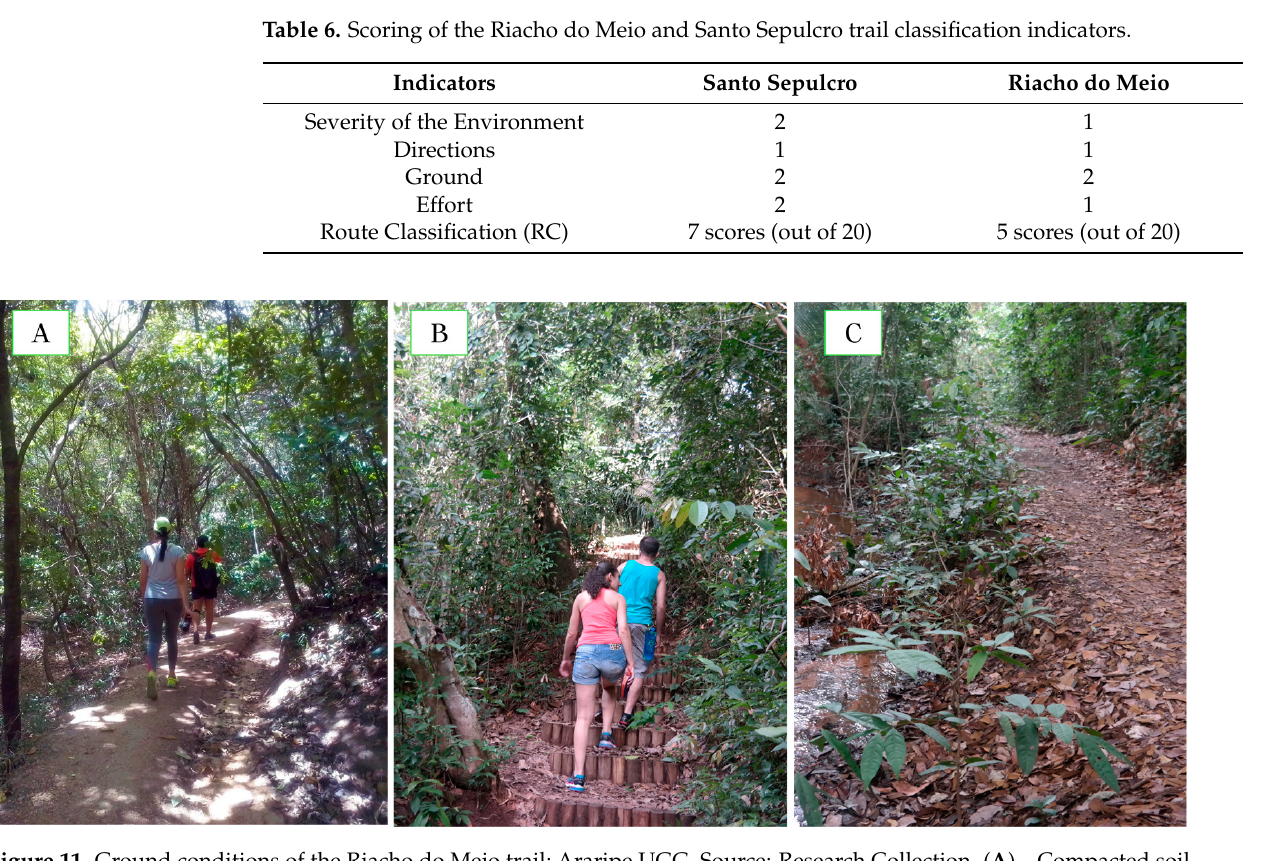
Figure 11. Ground conditions of the Riacho do Meio trail; Araripe UGG. Source: Research Collection. ( A )—Compacted soil and single track; ( B )—Wooden stairs; ( C )—Paths with streams on the bank.